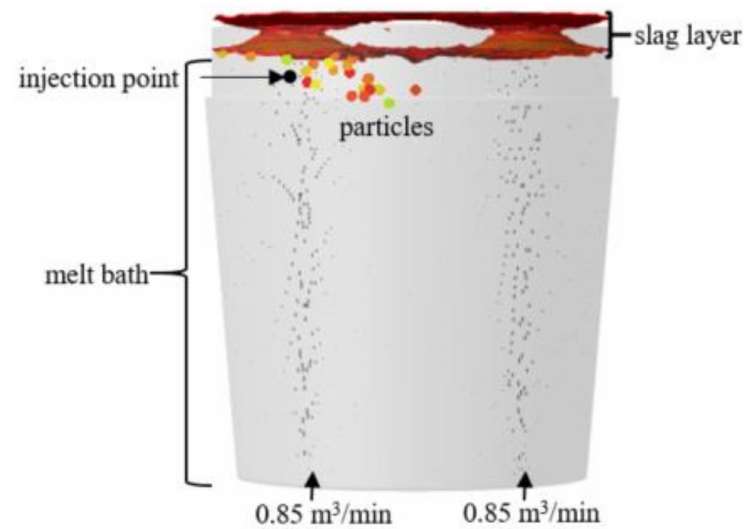
Figure 11. Particle release using point injection model.